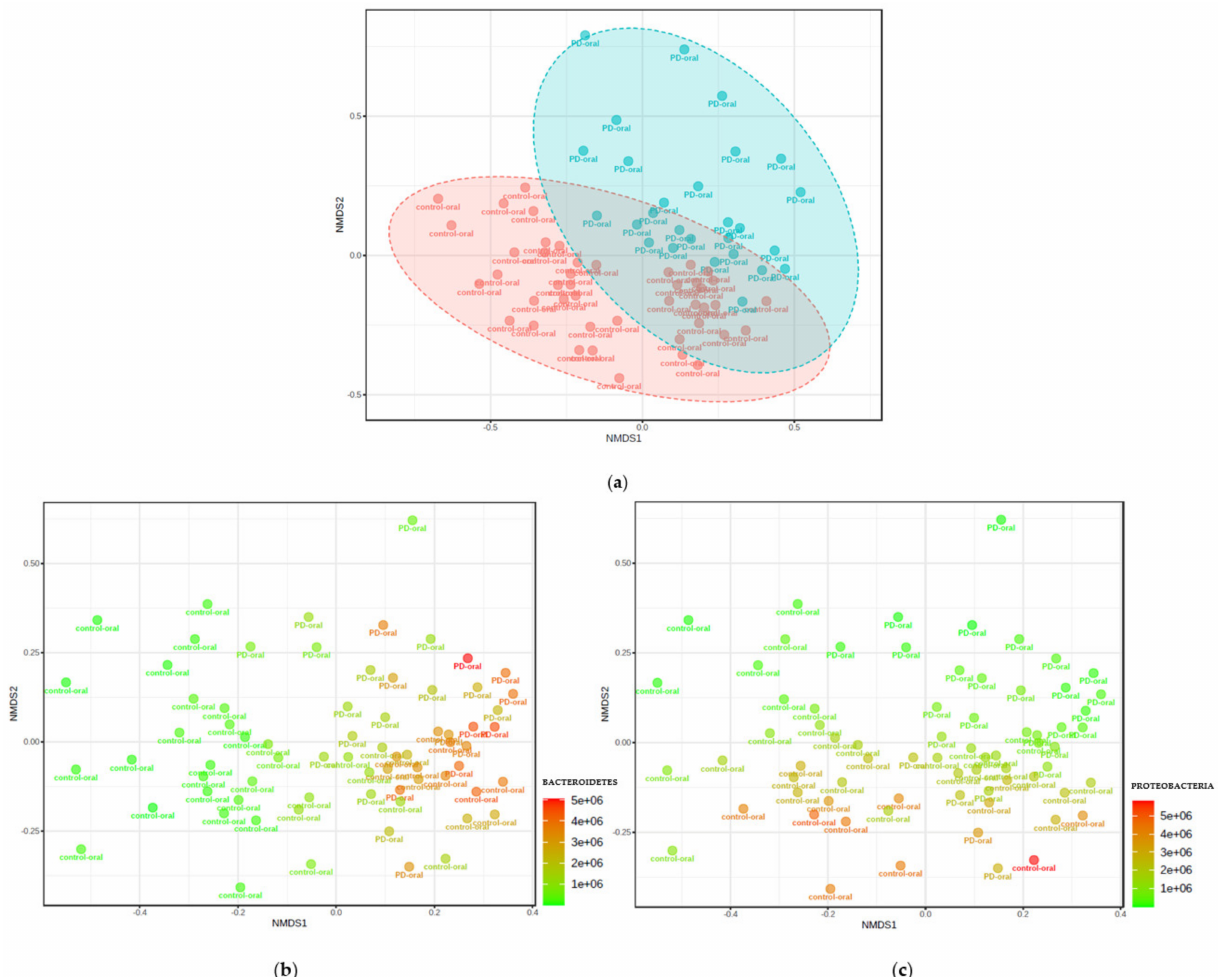
Figure 3. Visualization of oral microbial communities in patients with PD and healthy controls using non-metric multidimensional scheme. D stress values for all NMDS plots = 0.20593. ( a ) Samples from patients with PD are indicated in blue and healthy controls are indicated in red. The 95% confidence intervals around the centroids for each group are shown. Oral microbiomes in patients with PD are significantly different from healthy controls, as demonstrated by analysis of similarity (ANOSIM); R = 0.2372 and p < 0.001. ( b ) Identical NMDS plot, with samples color-coded by the abundance of bacteria from the phylum Bacteroidetes. ( c ) Identical NMDS plot, with samples color-coded by the abundance of bacteria from the phylum Proteobacteria. The strength and statistical significance were calculated based on a categorical variable found in the same mapping file. An R-value near 1 indicates dissimilarities between the groups, while 0 indicates no significant dissimilarities between the